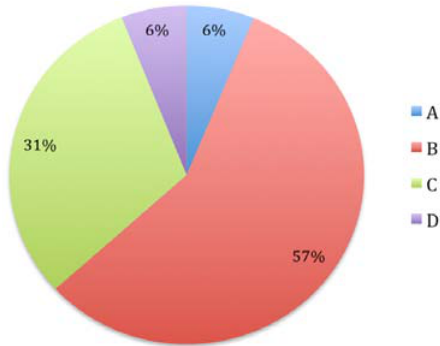
Figure 12 Duke's staging of the colorectal